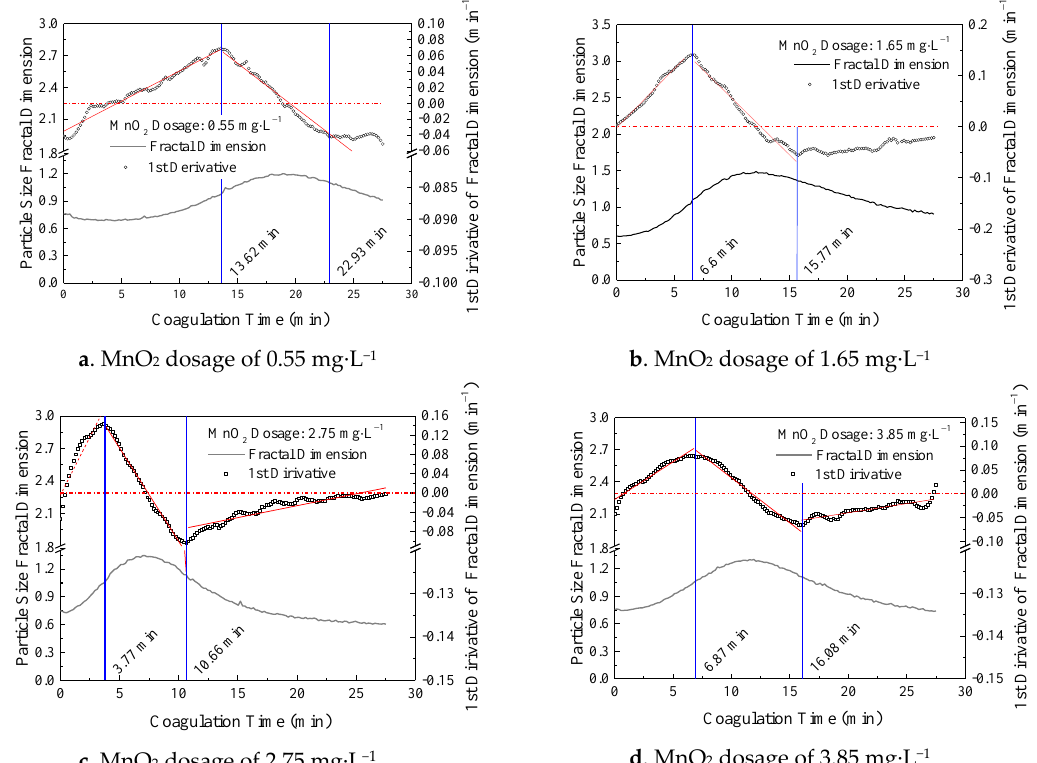
Figure 5. Change in particle size fractal dimension and its first derivative as a function of coagulation time. ( a )–( d ) MnO 2 dosage of 0.55, 1.65, 2.75, and 3.85 mg·L −1 .